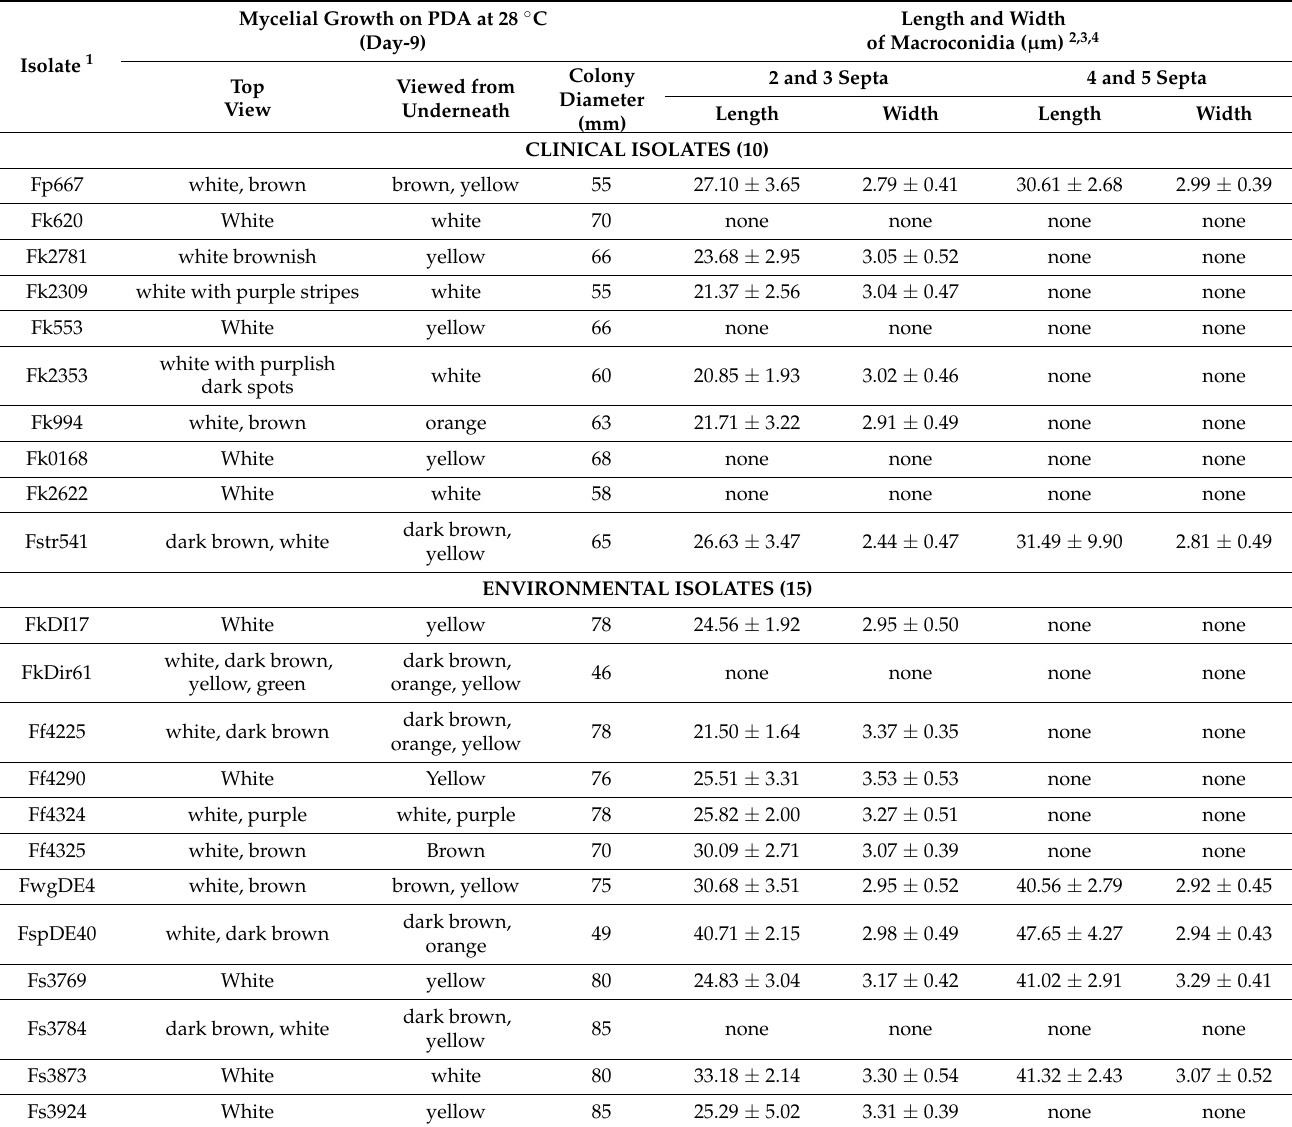
Table 2. Morphological features of FSSC